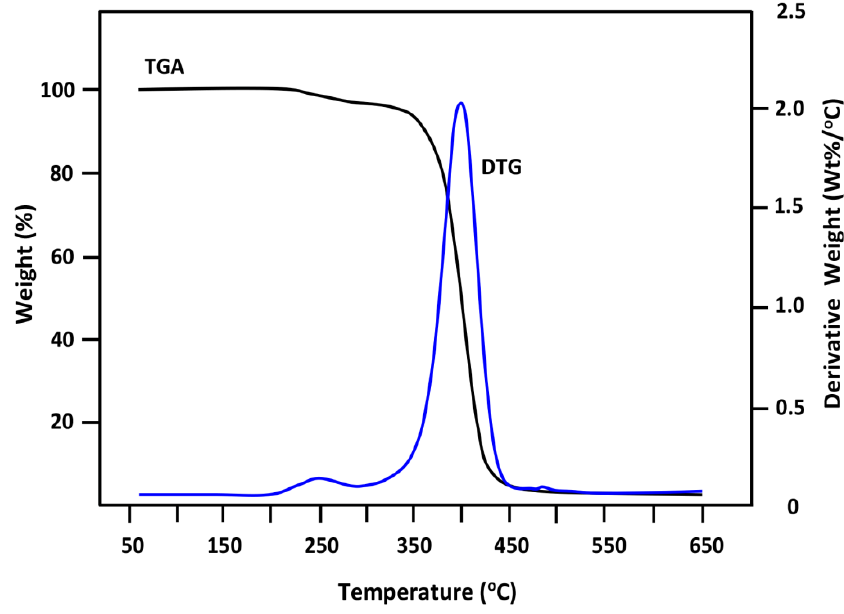
Figure 5. Thermograms TGA/DTG of the prepared PMMA.